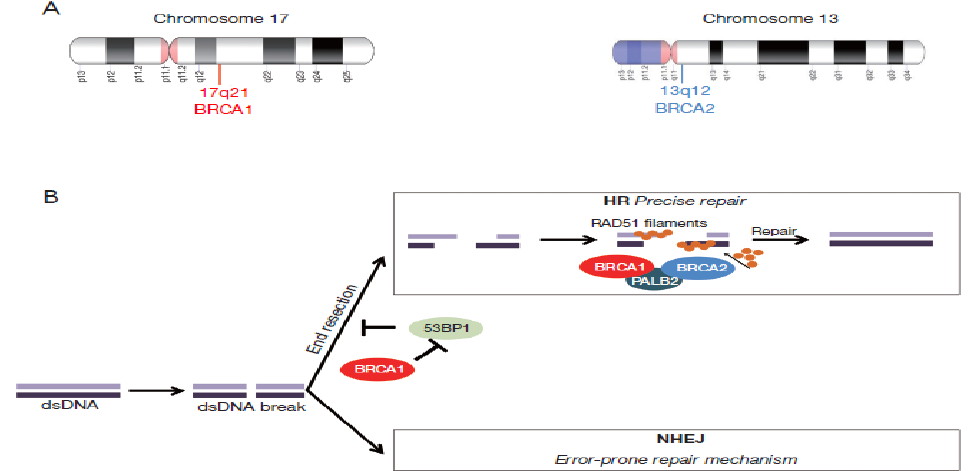
Figure 1. Overview of the roles of BRCA1 and BRCA2 in the DNA repair mechanism. ( A ). BRCA1 and BRCA2 loci on chromosomes 17 and 13, respectively. ( B ). The initiation of the double-stranded DNA (DSBs) break correction starts with BRCA1 binding to the site of damage, thus initiating the precise repair via homologous repair (HR) and preventing non-homologous end joining (NHEJ). Apart from breast and ovarian cancer, several PARP inhibitors have been investi-